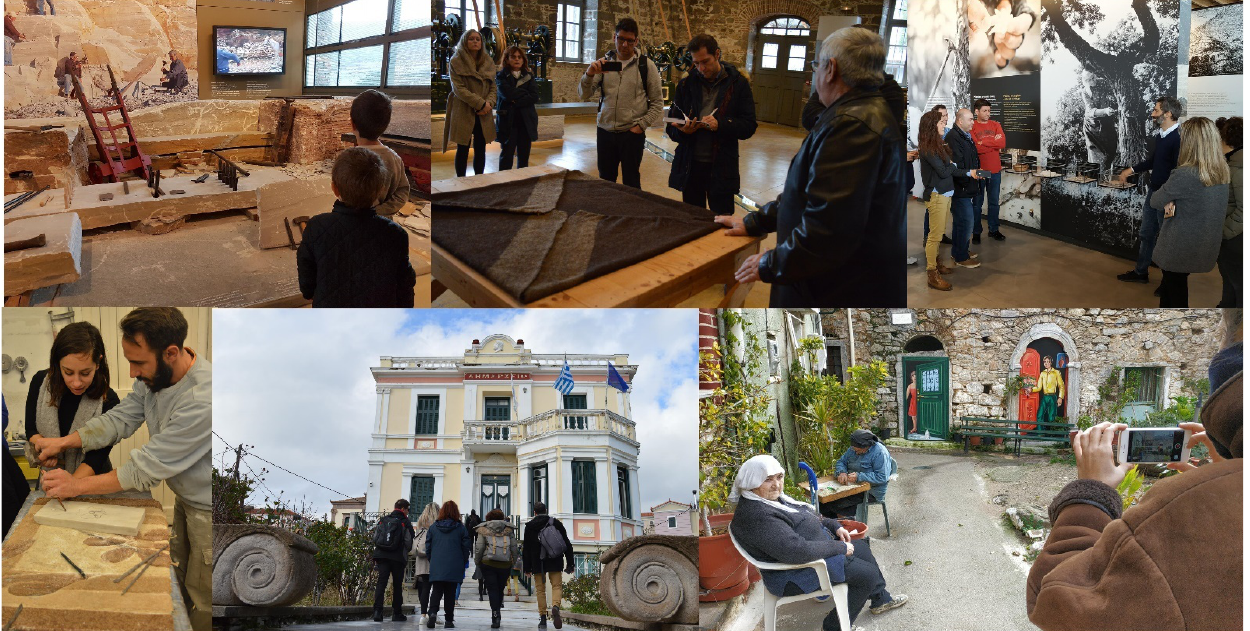
Figure 3. Photographs from field visits. Left, up: Tinos, museum of marble crafts; observation of two pupils who are watching a video in front of tools and marbles in the quarry section. Left, down: Tinos, settlement; a member of the design team is learning to apply marble sculpting tools in a workshop. Center, up: Lesvos, museum; a master of olive oil production explains the works to the design team. Center, down: Lesvos, settlement; the design team on their way to the town hall, one of the historic buildings in the settlement. Right, up: Chios, mastic museum; guided tour. Right, down: Chios, settlement; a member of the design team taking video notes.